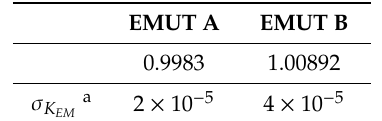
Table 5. EMUTs A and B calibration at nominal sinusoidal conditions.